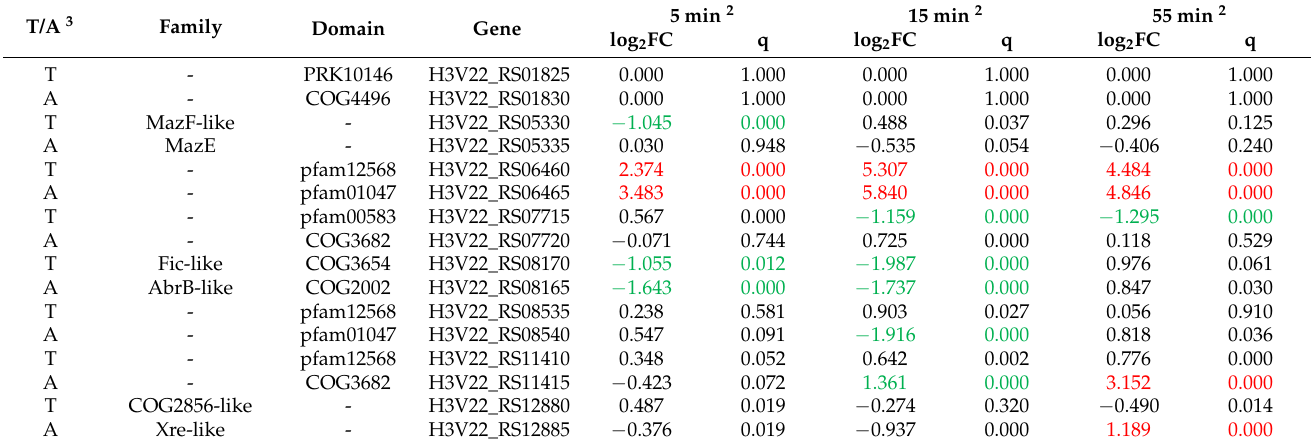
Table 2. Transcript levels of host toxin-antitoxin (TA) system genes during phage SA1 infection 1